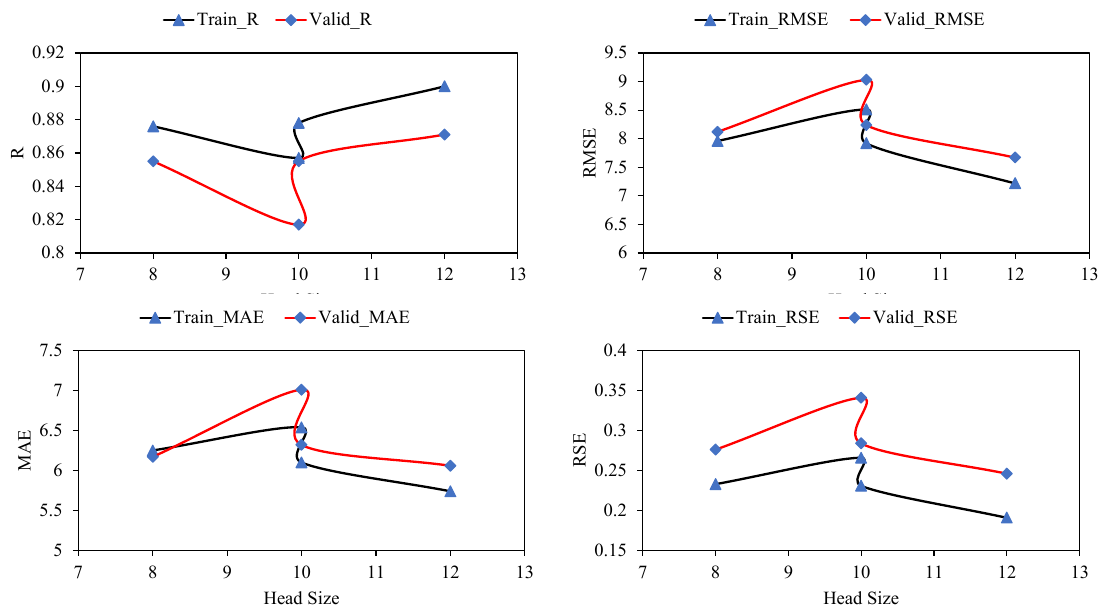
Table 5. Details of trials undertaken for hyperparameter selection for the GEP model. Figure 5. Effect of head size on statistical evaluation of the developed GEP Figure 5. Effect of head size on statistical evaluation of the developed GEP models.